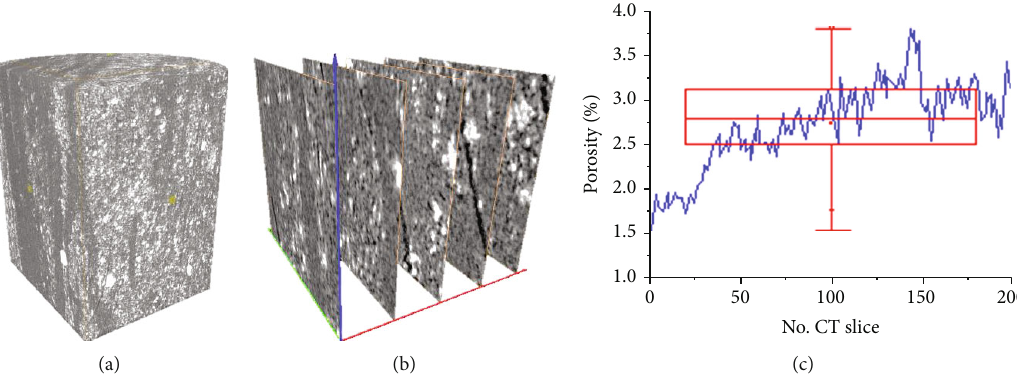
Figure 1: CT scan result: (a) a three-dimensional reconstructed coal sample; (b) distribution of cleat aperture of the coal sample; (c) mean porosity distribution.